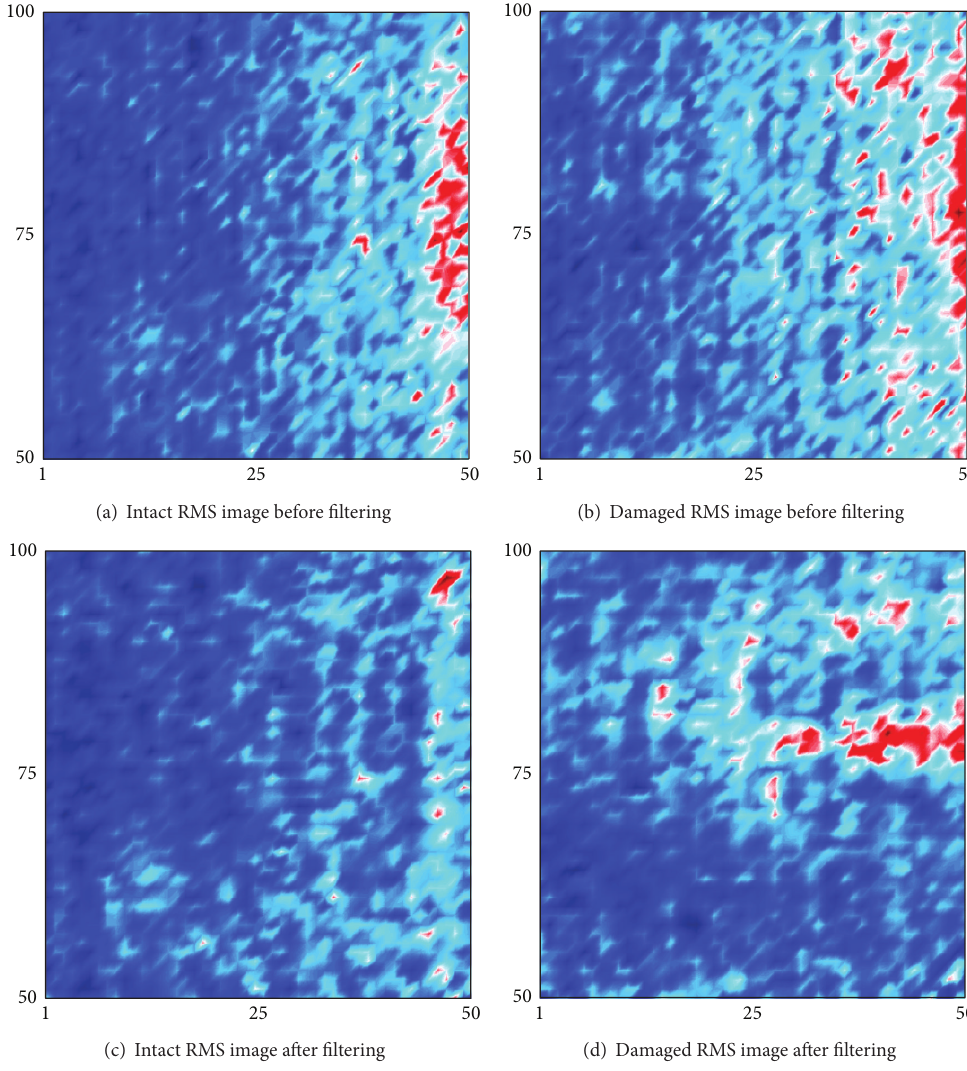
Figure 16: Comparison of RMS snapshots at 130 𝜇 s for damage case